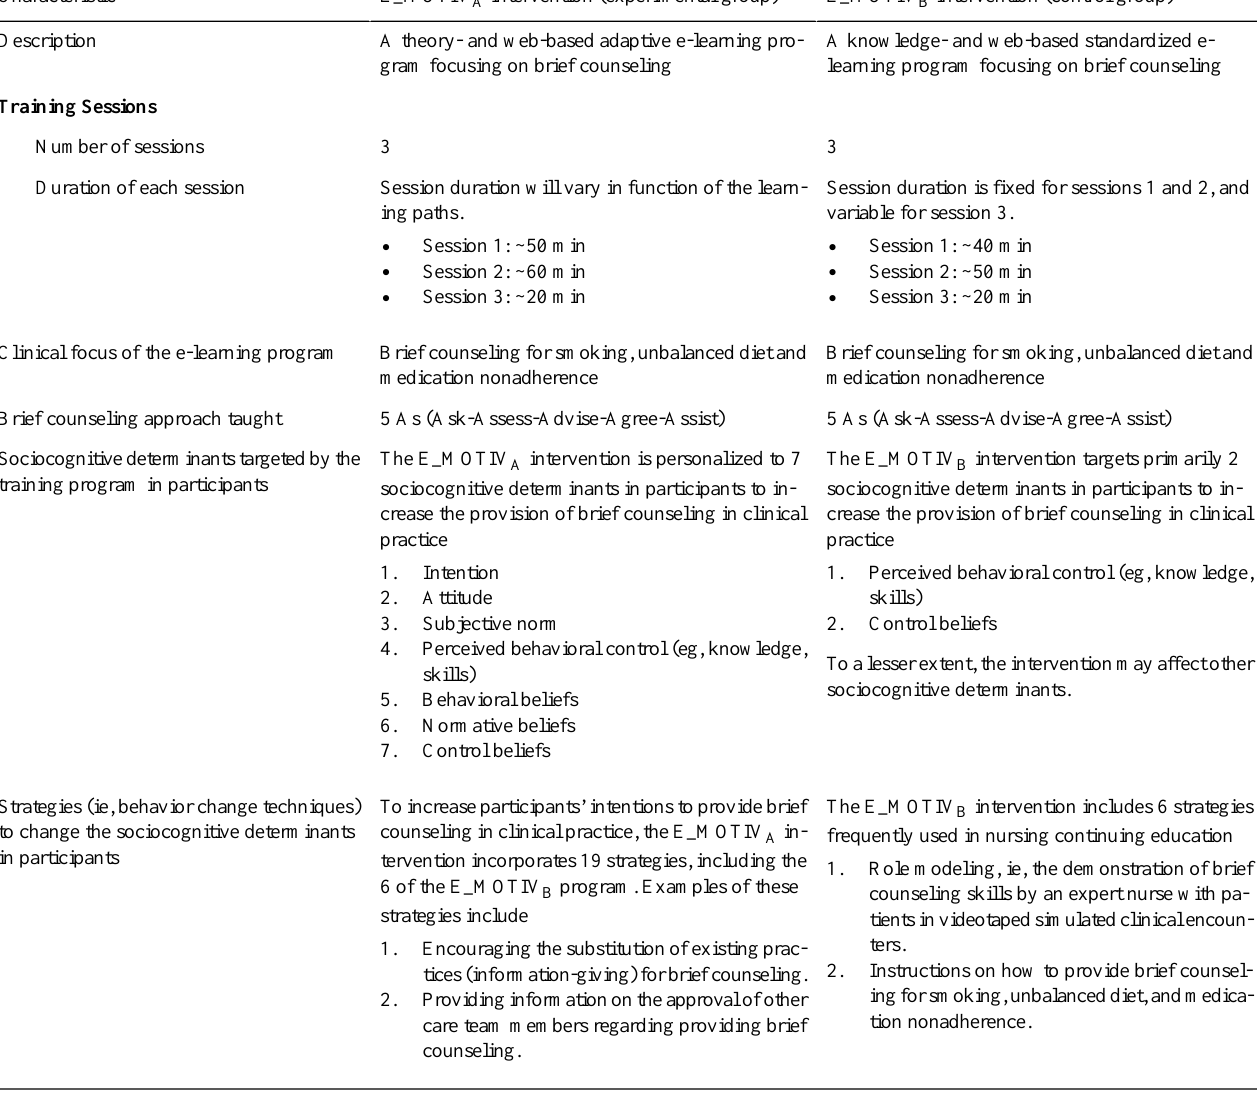
Table 1. A high-level description of the E_MOTIV A and E_MOTIV B interventions.